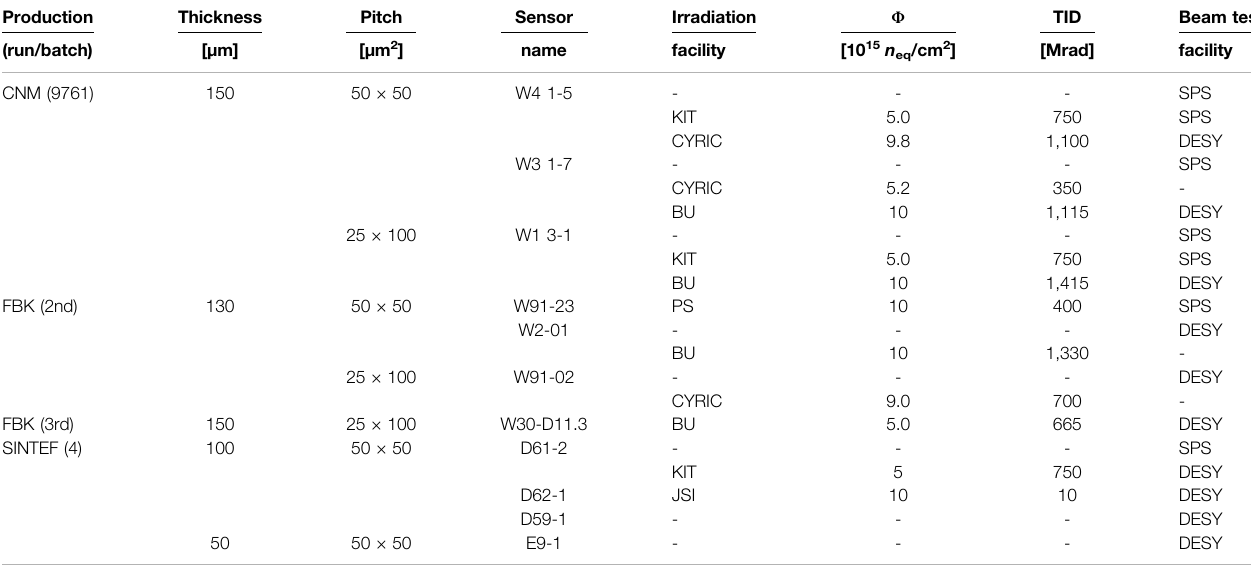
TABLE 1 | List of RD53A 3D pixel module studied in laboratories and with beam test experiments.